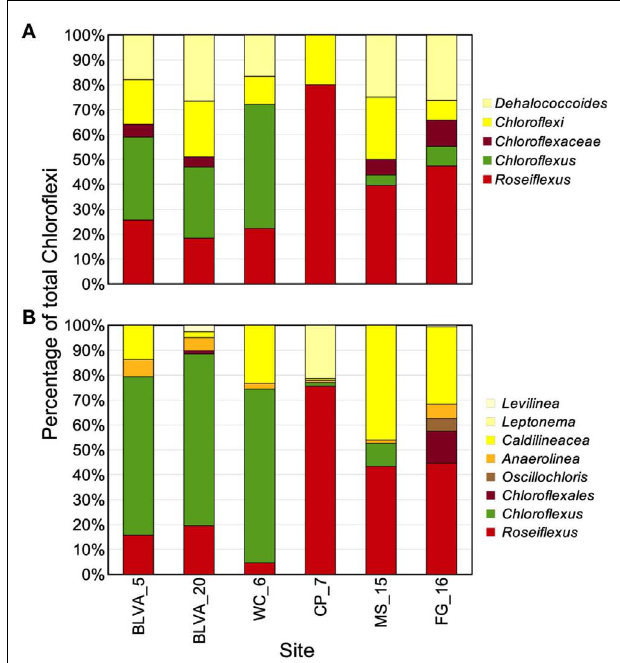
FIGURE 6 | Comparison of Chloroflexi phylogenetic marker genes from metagenomes and Chloroflexi 16S rRNA clones . Phylogenetic marker genes within the metagenome sequences assigned to the phylum Chloroflexi using AMPHORA (A) compared to the identity (confidence threshold of 80%) of Chloroflexi-like 16S rRNA genes (B) observed in the ribosomal clone library ( n ∼ 300 per site).Taxonomic groups of Chloroflexi: red = Roseiflexus spp., green = Chloroflexus spp., brown shades = other taxa within the order Chloroflexales, and yellow shades = other taxa within phylum